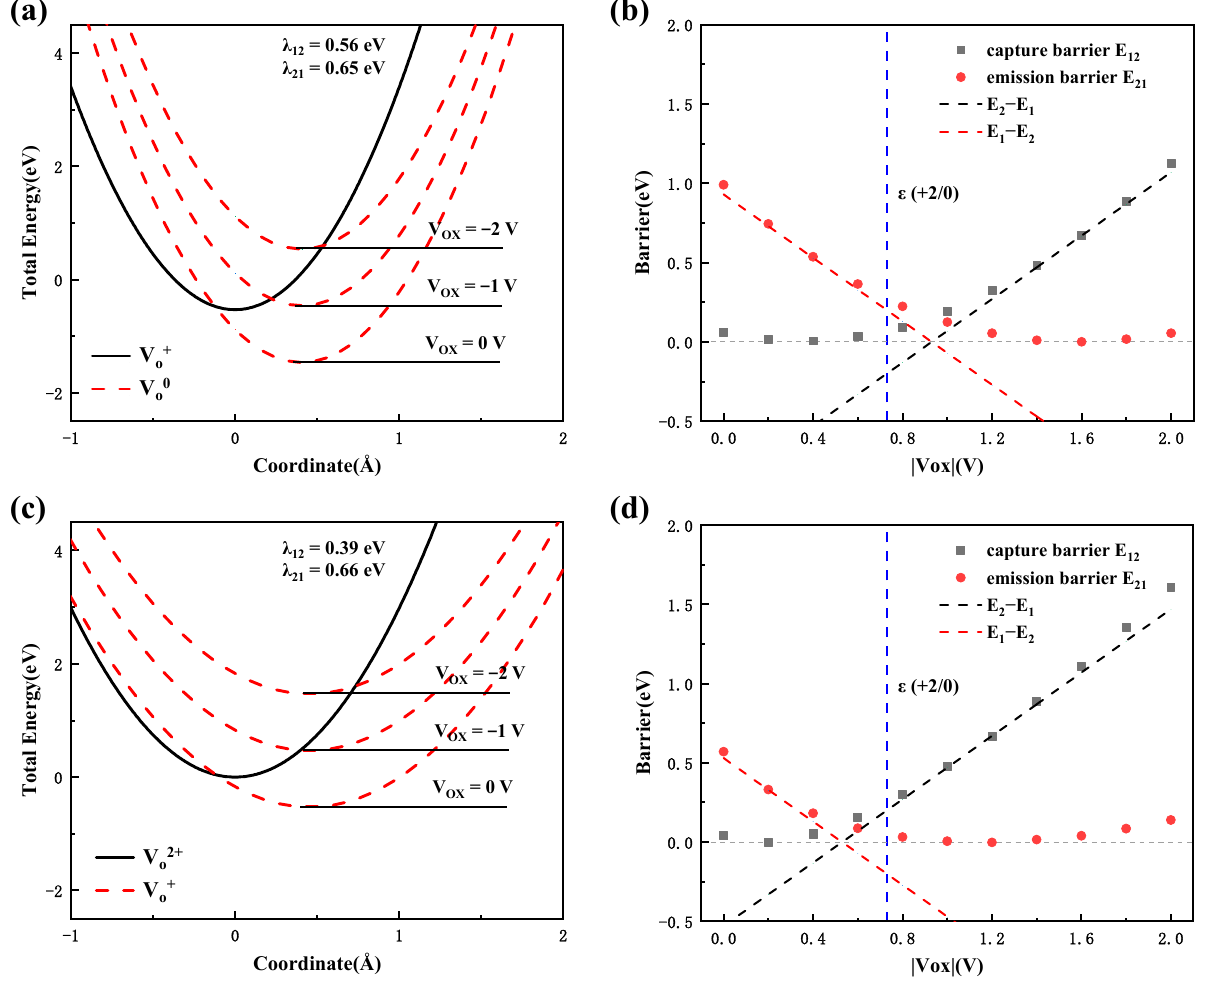
Figure 12. The total energy as a function of reaction coordinates for the oxygen vacancies in CAAC- IGZO active layer, ( a ) from V 0 to V + and ( c ) from V + to V 2 + . The red dashed line is the total energy (cid:2868) to V (cid:2878) and ( c ) from V (cid:2878) to V (cid:2870)(cid:2878) . The red dashed line is the total en- O O O O (cid:2899) (cid:2899) (cid:2899) (cid:2899) curve for the charge state at different V ox . The energy barrier as a function of V ox , ( b ) from V 0 to V + O O . The energy barrier as a function of V , ( b ) from V (cid:2899)(cid:2868) (cid:2925)(cid:2934) (cid:2925)(cid:2934) and ( d ) from V + to V 2 + . The blue dash line represent the transition level ε (+2/0). O O Overall, for the V 0 defect in the CAAC-IGZO active layer, when V ox is greater than O 0.73 V. the Fermi level is below the transition energy level ε (+2/ − 0), the defects